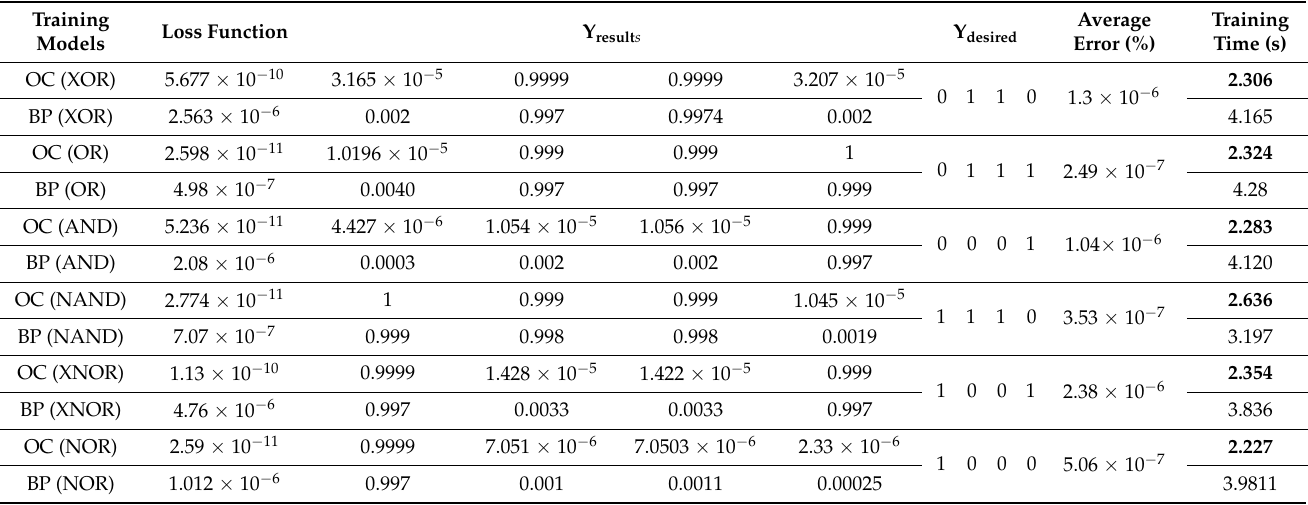
Figure 8. ( A ) Input control u with optimality condition ( B ) dH/du . Table 2. Comparison results of two training algorithms with different models.